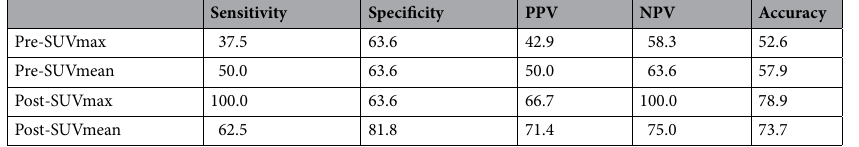
Table 2. Diagnostic accuracy of PET imaging parameter between MET uptake of Grades 1, 2, and 3. The cutoff values for pre-SUVmax, pre-SUVmean, post-SUVmax, and post-SUVmean were 7.48, 4.69, 6.21, 3.64, respectively. PPV , positive predictive value; NPV , negative predictive